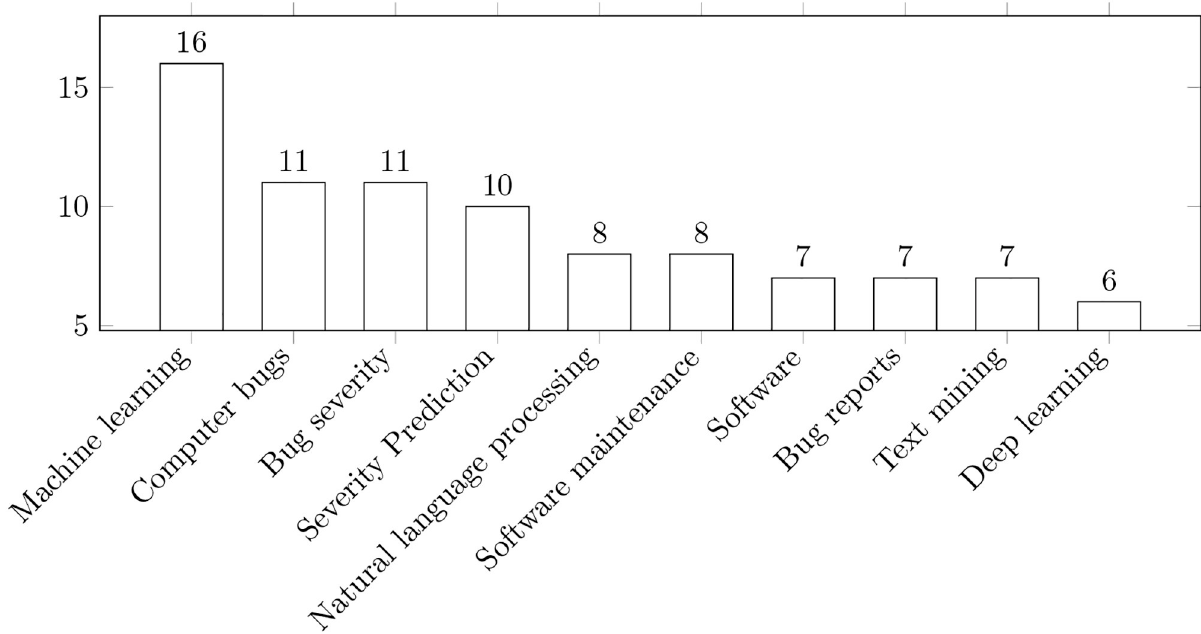
Fig 8. Tags distribution among the papers included in the final reading log. The bars show the number of papers related to a specific tag. Note: several tags can be assigned to one paper.